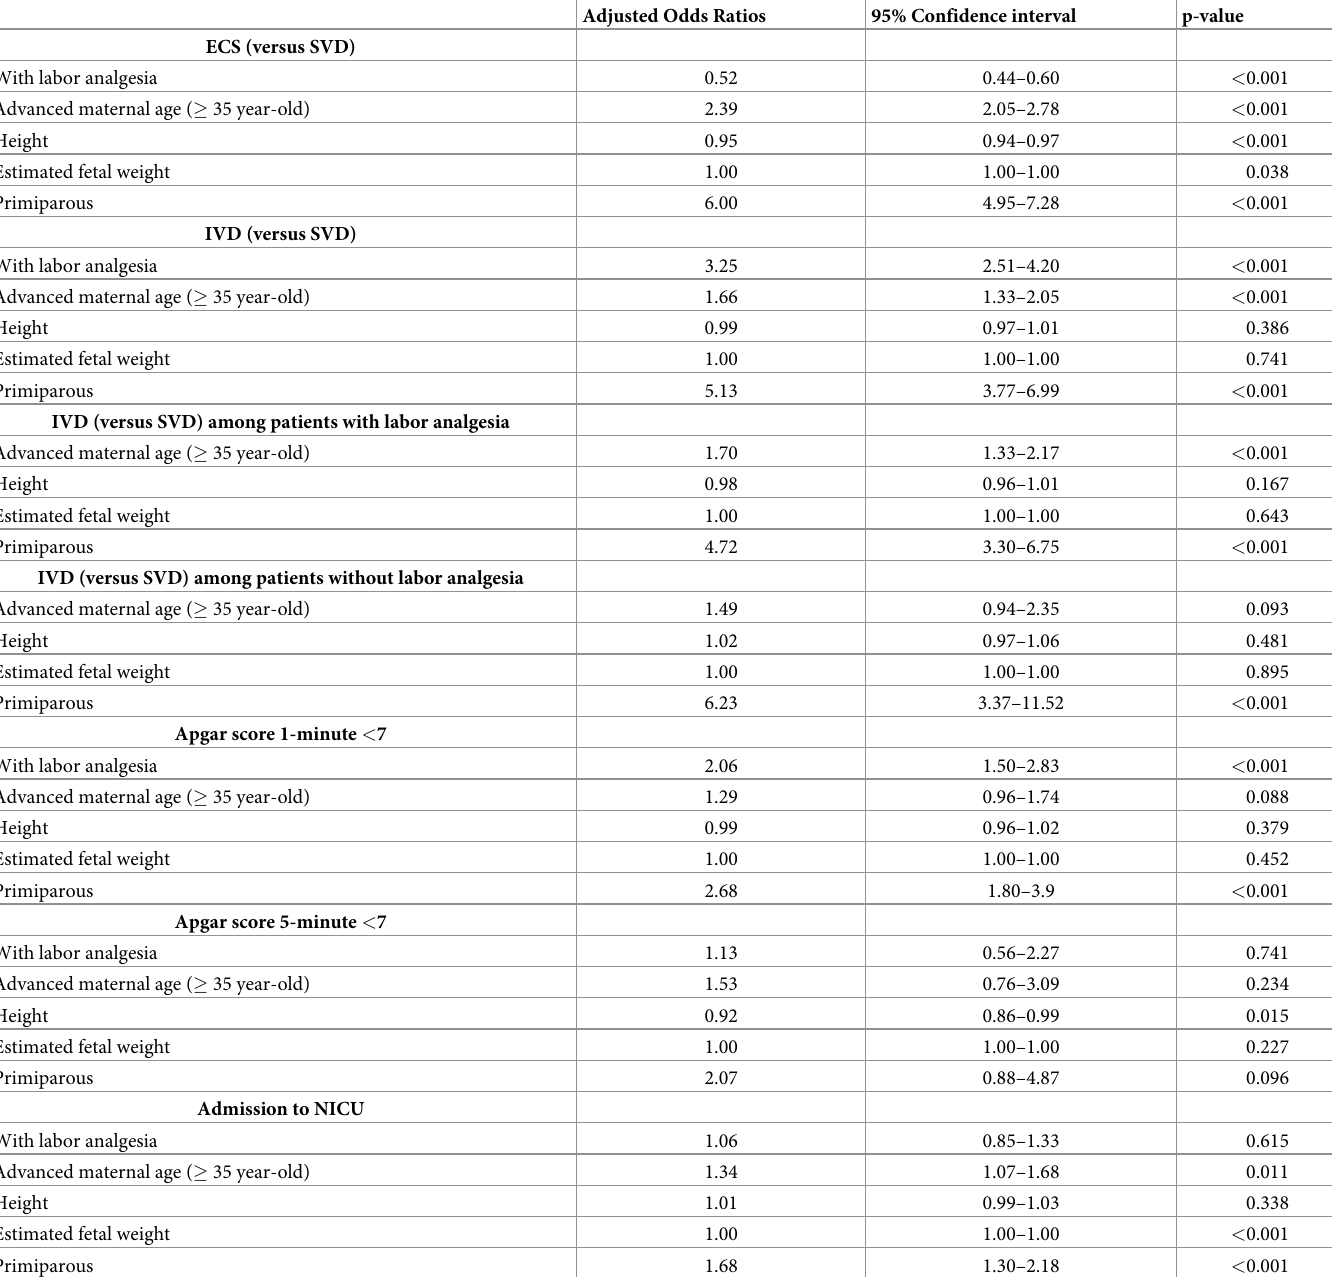
Table 3. The risk of labor analgesia against instrumental vaginal delivery and emergency cesarean section, and adverse neonatal outcomes at obstetrics inpatients. (N =